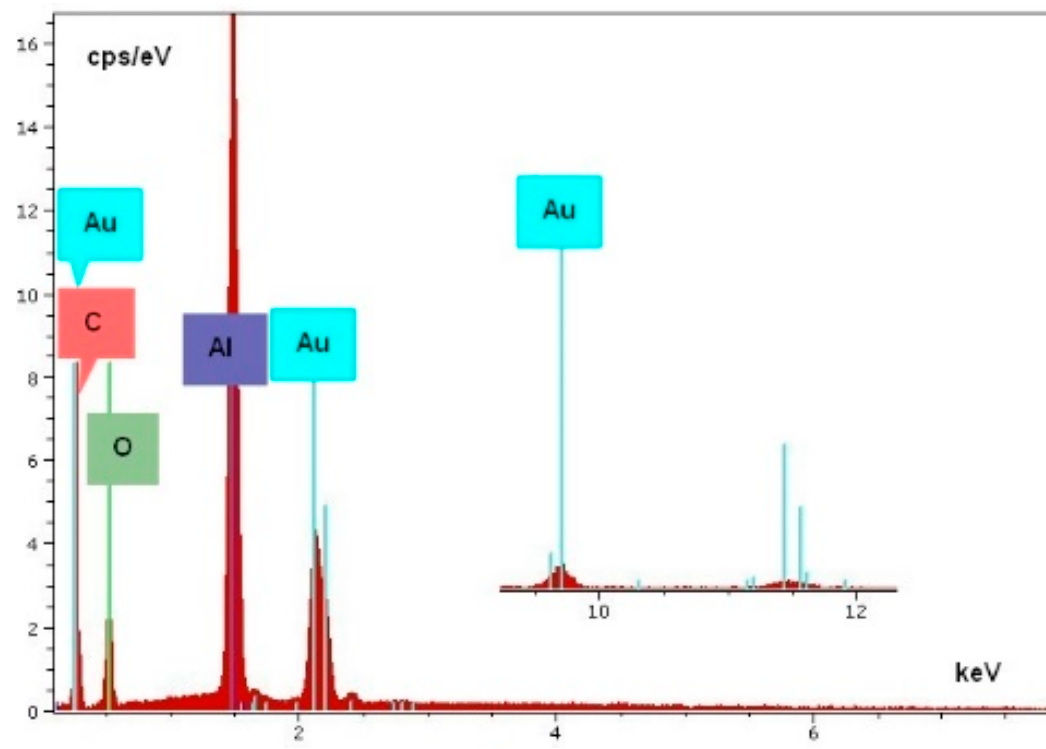
Figure 8. Typical EDS spectrum of the thin dendrite structures on the substrate.